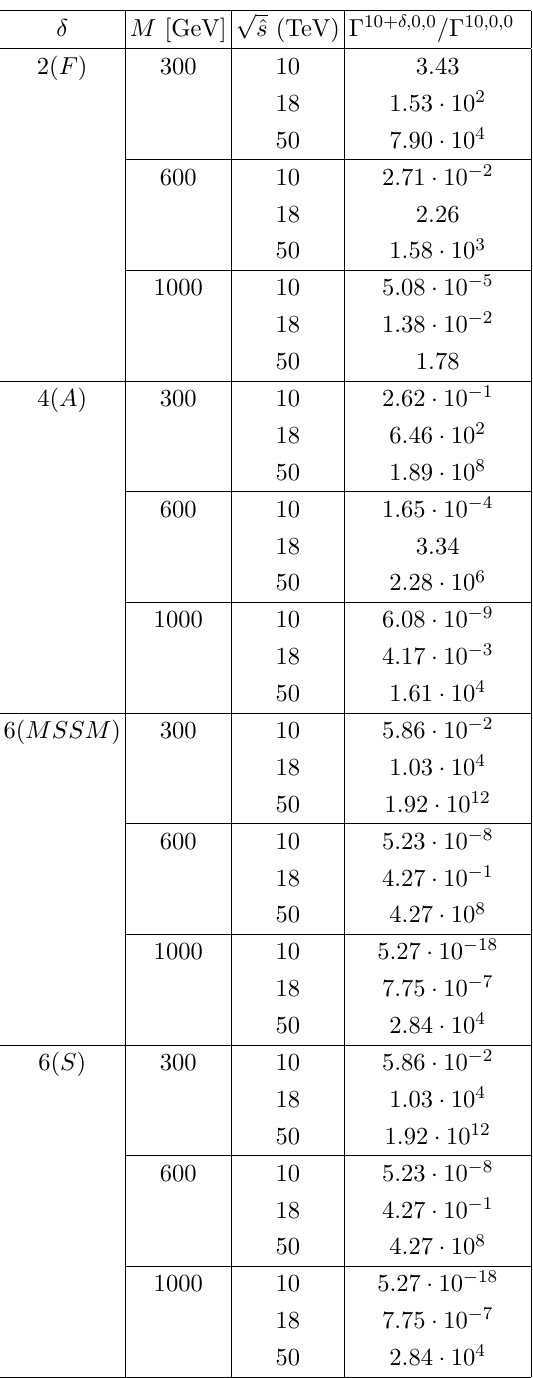
Table 1. Enhancement factors for example